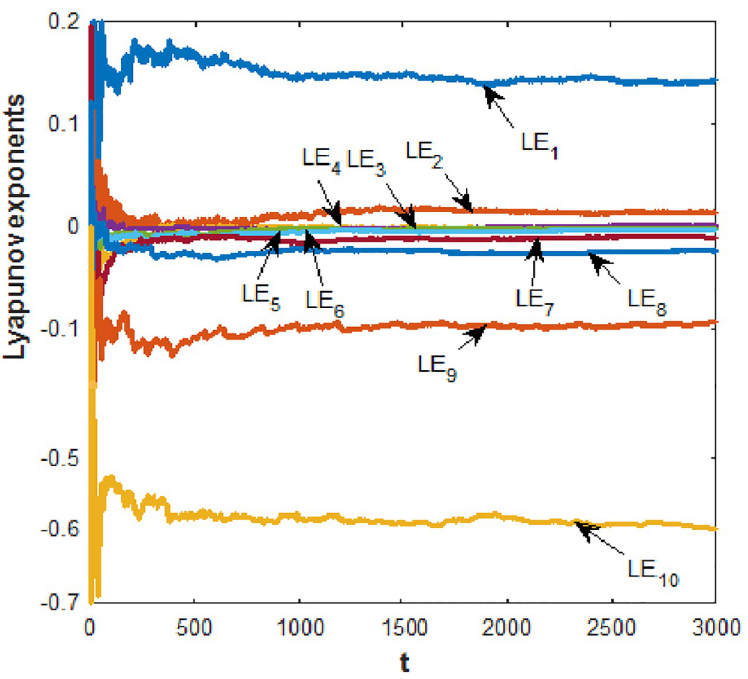
Fig 2. Lyapunov exponents of the new 10-D hyperchaotic system (1) with a = 0.1, b = 0.1, c = 1.1 and d = 0.01.